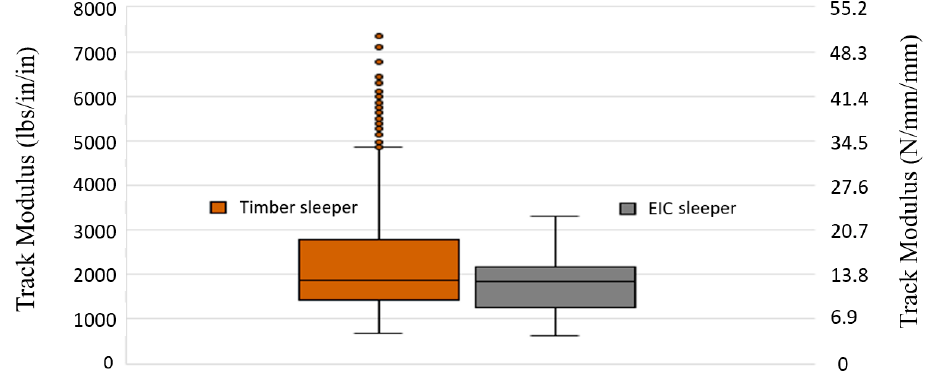
Figure 12. Comparison of the track modulus between the timber and EIC sleepers, considering all measured locomotive and passenger coach field data.